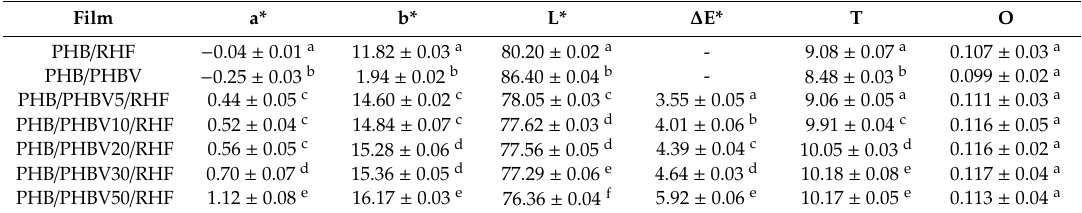
Table 2. Optical properties of the thermo-compressed films made of poly(3-hydroxybutyrate)